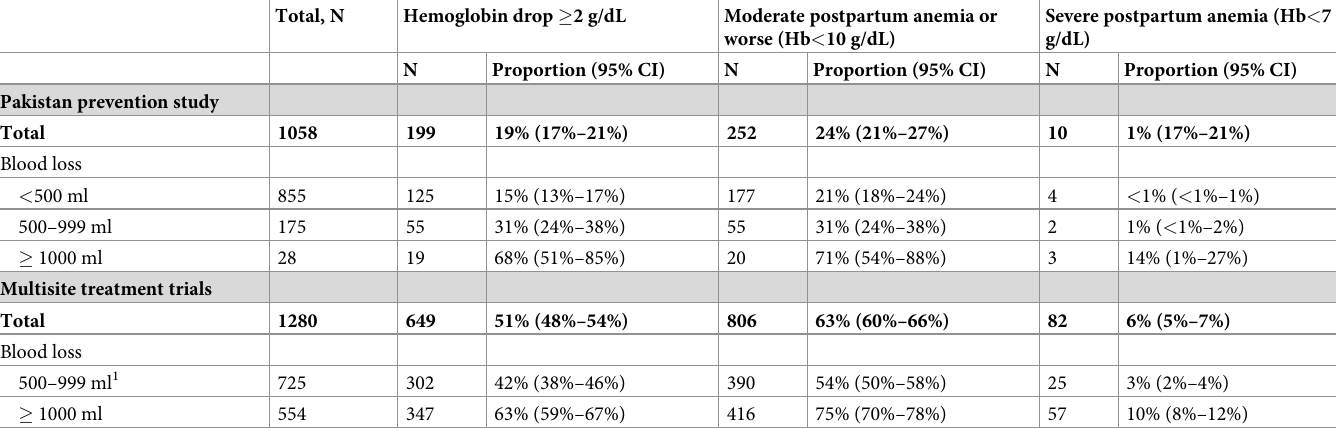
Table 3. Association of common threshold definitions of postpartum hemorrhage with a clinically important drop in pre- to post-delivery hemoglobin � 2 g/dL, moderate postpartum anemia (i.e. hemoglobin < 10 g/dL), and severe postpartum anemia (i.e. hemoglobin < 7